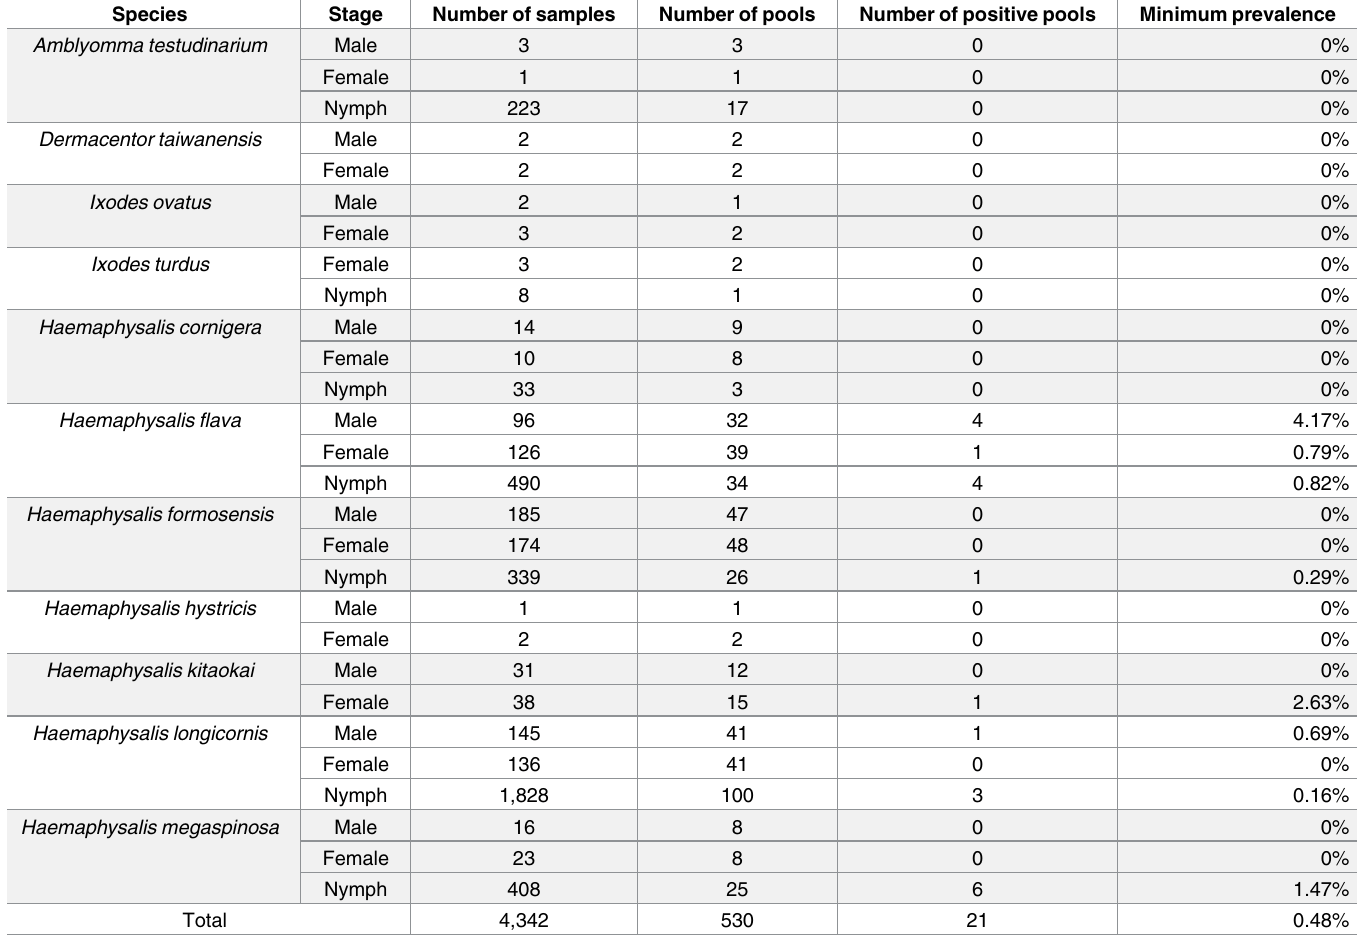
Table 2. Host-seeking ticks collected in Wakayama Prefecture. Species